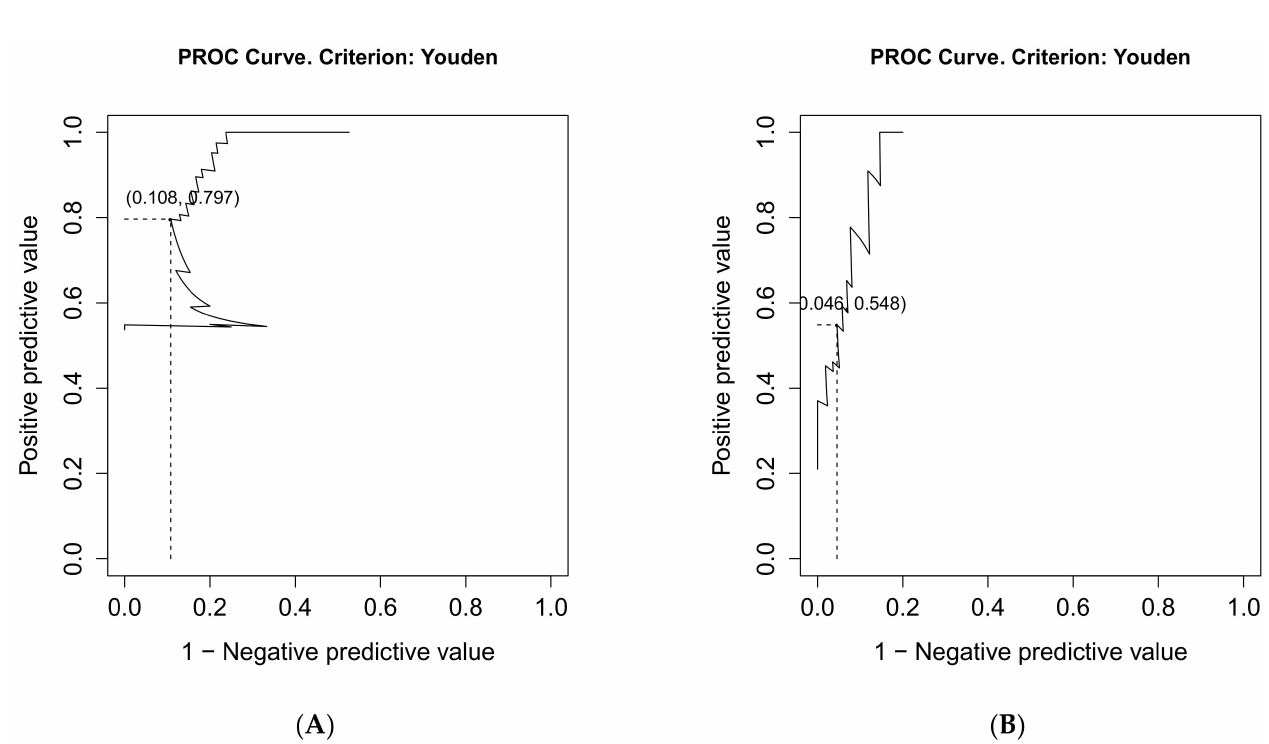
Figure A1. Predictive receiver operation characteristic (PROC) curve for beta-hydroxybutyrate concentration (BHB) on the tenth day post partum for hyperketonemia ( A ) and subclinical ketosis ( B ). Optimal cut point was calculated based on the minimization of the Youden’s index. Table A1. Summary of t -test analysis to evaluate the difference in biomarker concentration in hyperketonemia